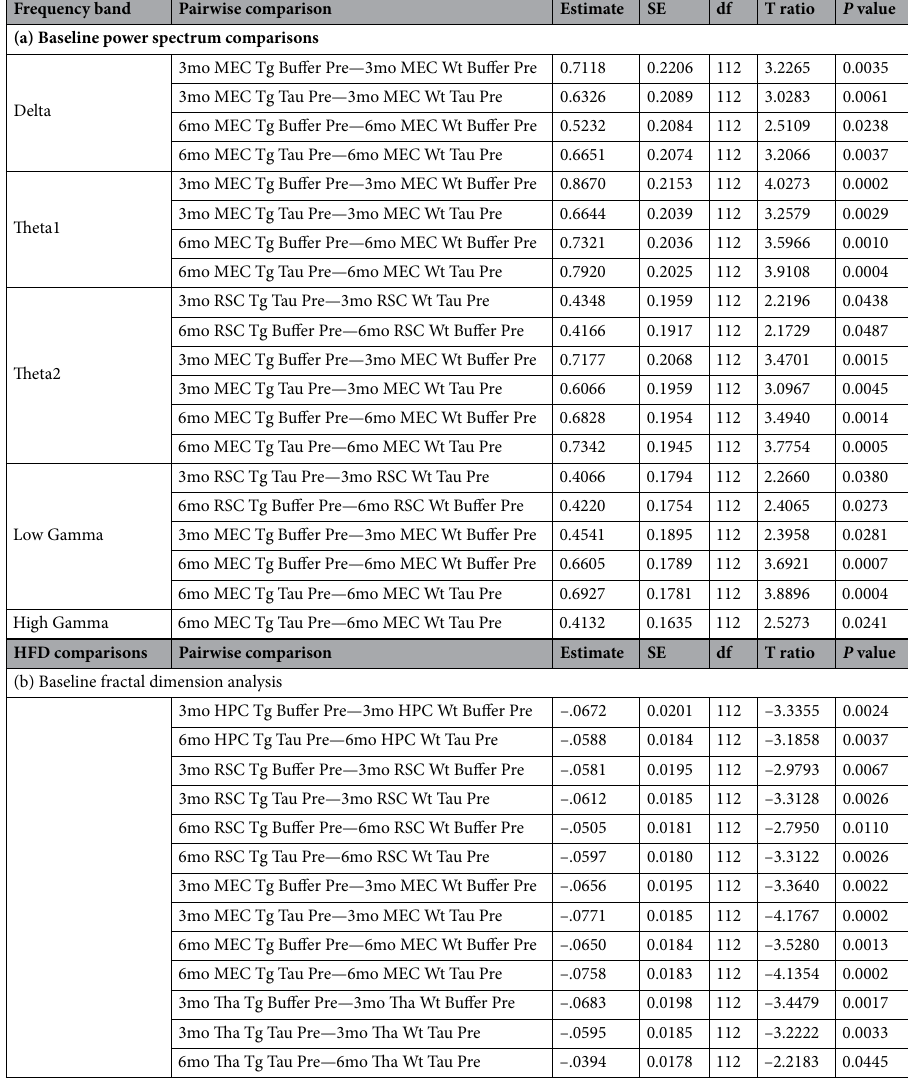
Table 2. Table containing the pairwise comparisons of quantified power spectra values and Higuchi fractal dimension values of animals at baseline conditions. Pairwise comparisons between (a) power spectra band values and (b) fractal dimension between APP.PS1 animals and wild-type animals prior to injection. 3mo and 6mo refer to 3- or 6-months old animals. Pre refers to Pre-injection timepoint. MEC refers to Medial Entorhinal Cortex, HPC refers to Hippocampal CA1, Tha refers to thalamus, RSC refers to Retrosplenial Cortex. HFD refers to Higuchi fractal dimension. TG refers to APP.PS1 animals, WT refers to wild-type. Tau refers to tau-seeded mice, Buffer refers to phosphate-buffered saline injected mice. SE refers to standard error. Df refers to degrees of freedom. Estimate refers to the estimated difference in value between pairwise comparisons. mo refers to months-old at